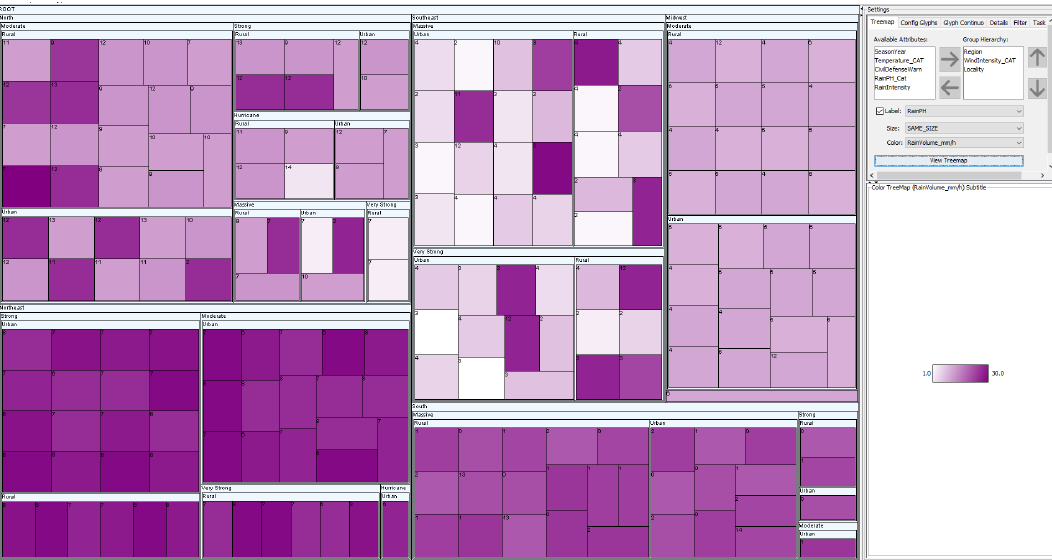
Figure 10. Visualization of Scenario Hierarchy (H) visualization configured for one of the user tasks. This visualization is a squarified Treemap with no glyphs.